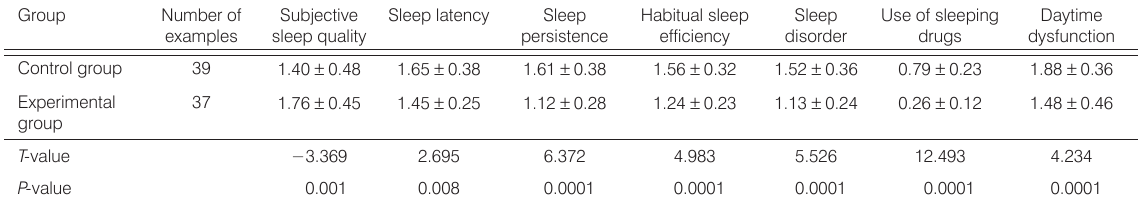
Table 3. Comparison of PSQI scores between the two groups after